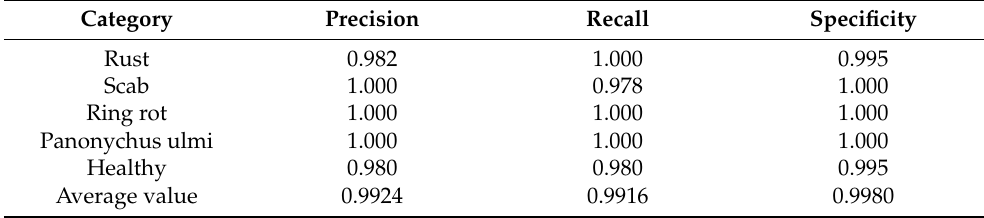
Table 4. The results of different